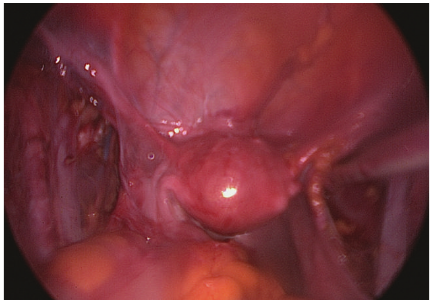
Figure 4: Final appearance of the external iliac vessels and uterus at the end of bilateral pelvic